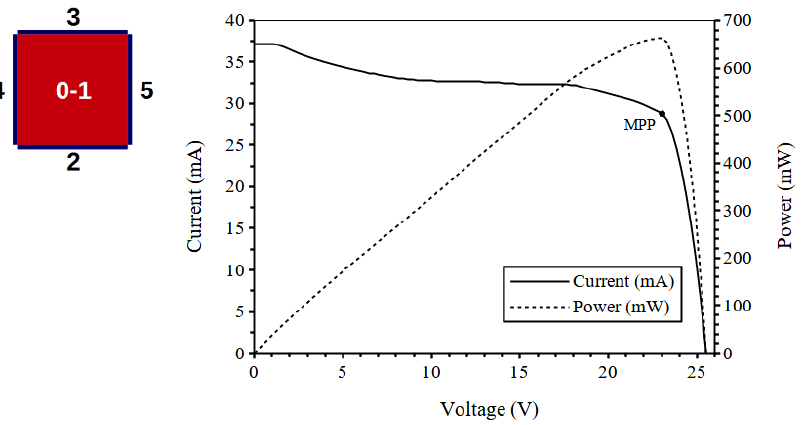
Figure 18. Characteristic curves (I-V and P-V) of the unshaded LSC panel with four 10-cells PV arrays and functionalized with 300 ppm of Lumogen ® F Red 305.